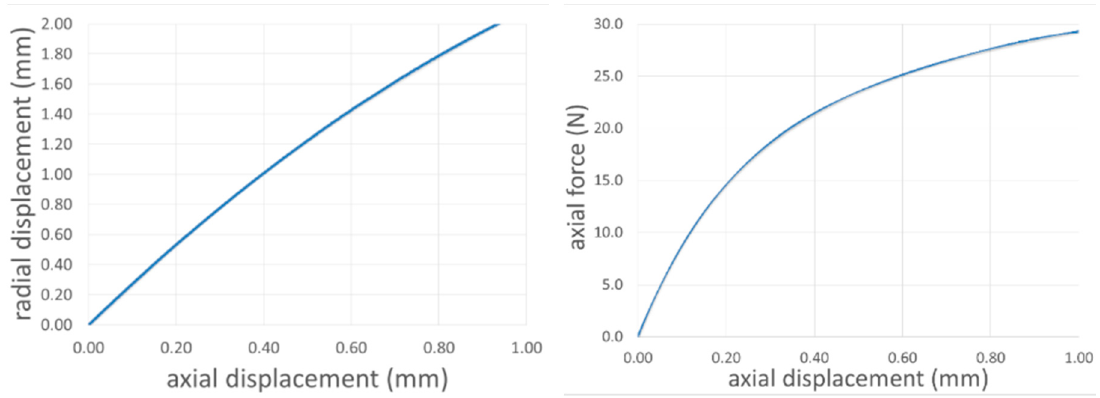
Figure 8. Cell radial displacement ( left ) and axial force ( right ) versus axial displacement. Actuators 2018 , 7 , x